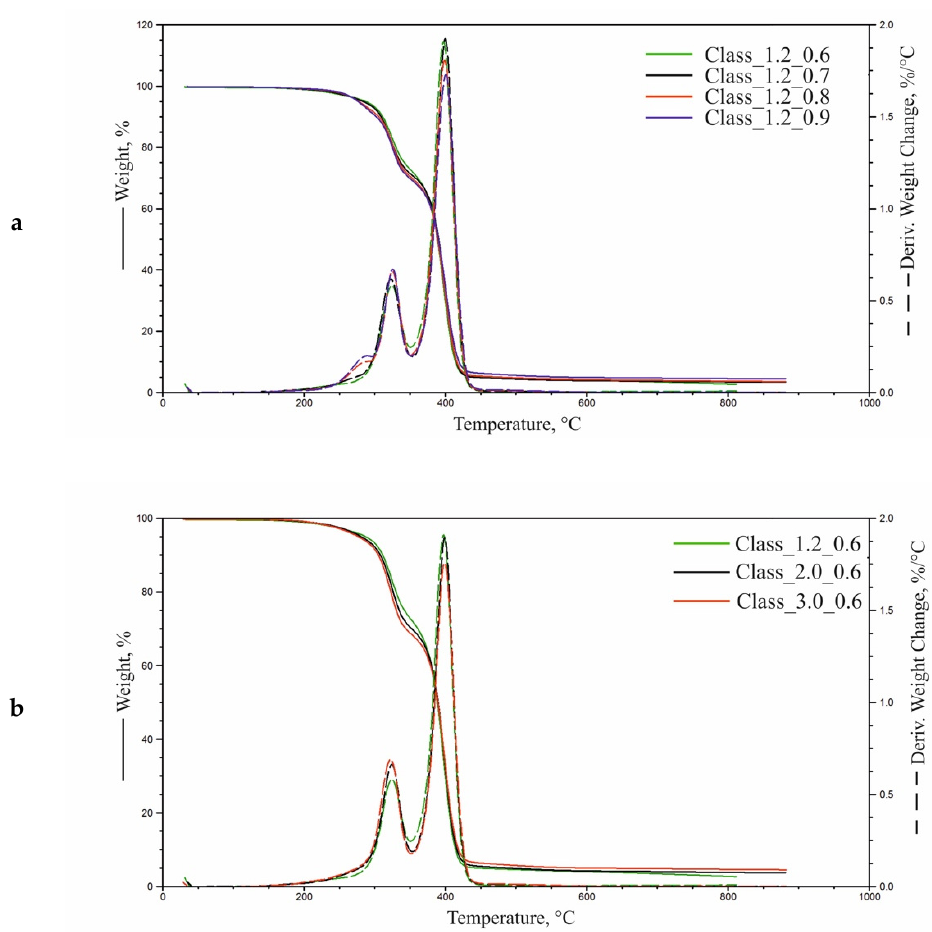
Figure 6. Thermogravimetric analysis (TGA) curves for ( a ) foams with different I NCO levels at a water content of 1.2 php and ( b ) foams with different water contents at I NCO = 0.6. Table 6. Foam parameters determined from thermogravimetric (TG) and derivative thermogravimetric (DTG)